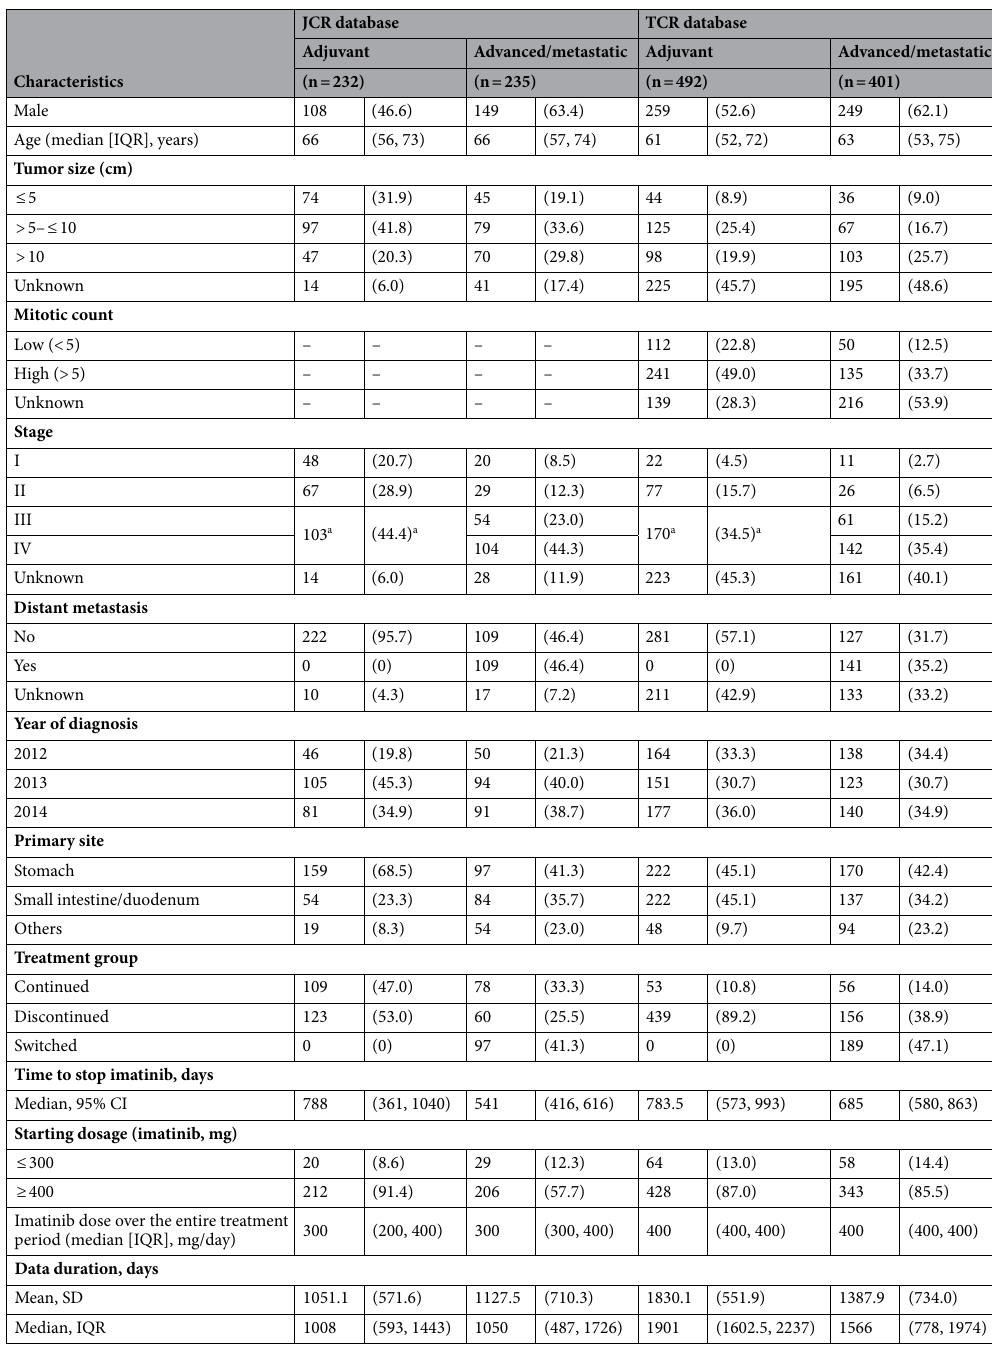
Table 1. Baseline characteristics of patients with GISTs in the JCR and TCR databases. GISTs Gastrointestinal stromal tumors, JCR Japanese Cancer Registry, TCR Taiwan Cancer Registry, CI Confidence interval, IQR Interquartile range, SD Standard deviation. a Stages III and IV are combined in the adjuvant setting due to the data regulation policy in